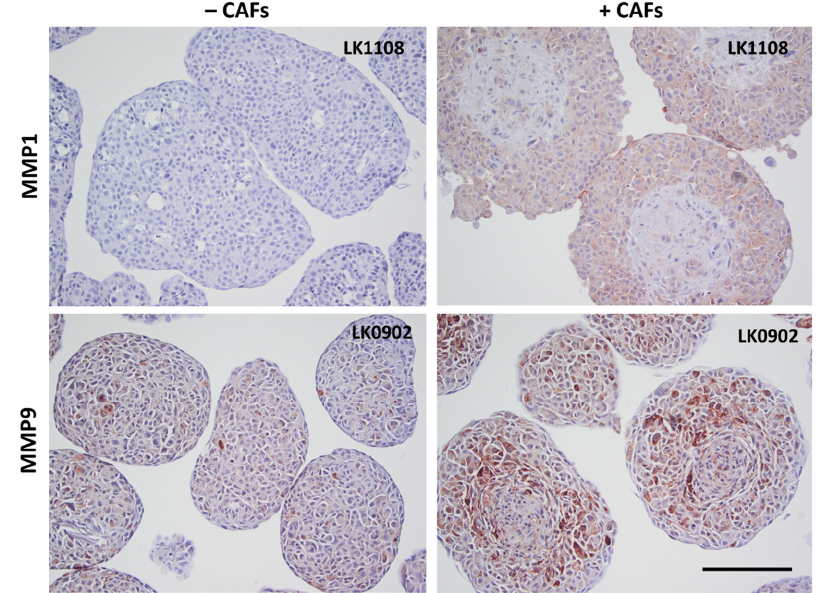
Figure 3. Verification of microarray with immunohistochemistry. Expression of MMP1 and MMP9 in 5-day-old tumor cell spheroids (±CAFs) by immunohistochemical staining. Scale bar = 200 µm.